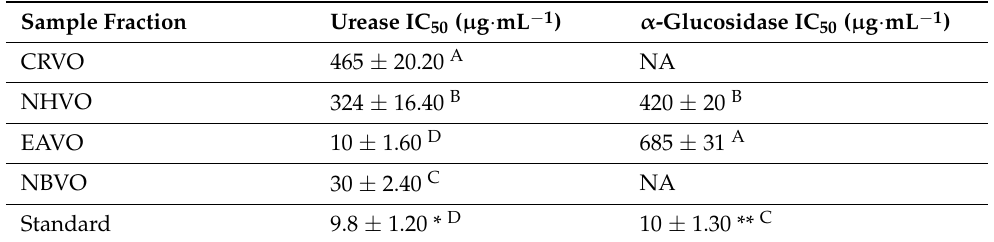
Table 2. Urease and α -glucosidase inhibition values of the methanolic crude extract of Verbena officinalis and its different fractions. Sample Fraction